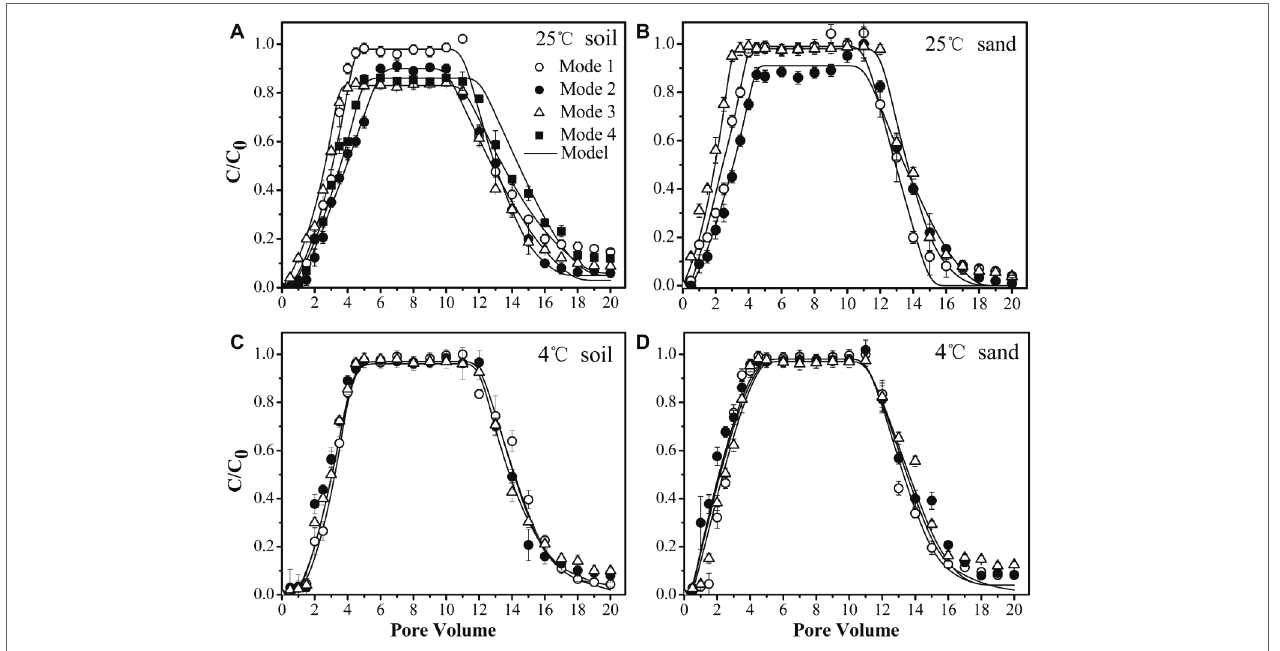
FIGURE 6 | Transport of chemotactic Pf 5RL through soil at 25°C (A) , sand at 25°C (B) , soil at 4°C (C) , and sand at 4°C (D) under different input modes. Input Mode 1, injection of bacteria only; Input Mode 2, co-injection of bacteria and naphthalene; Input Mode 3, injection of naphthalene immediately followed by